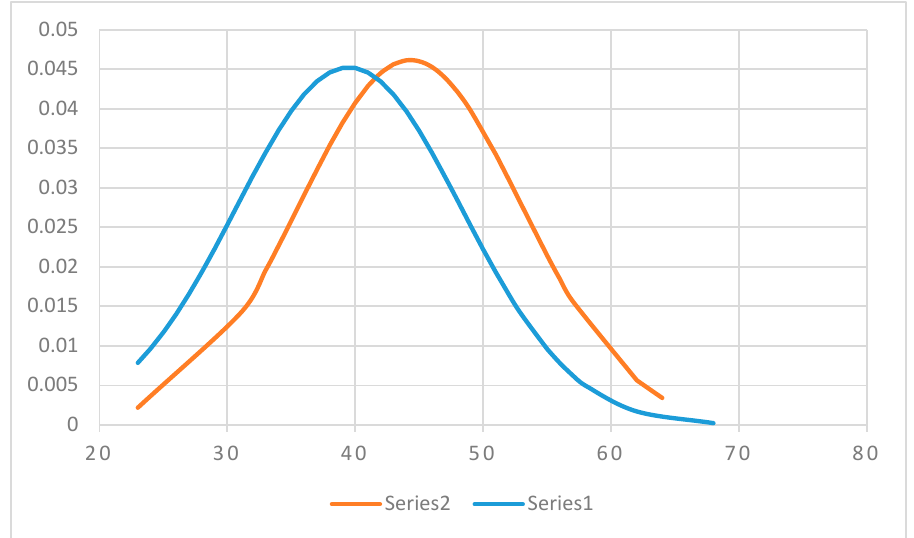
Figure 6. Simple (Series 1) and complex (Series 2) endometrial hyperplasia histopathological (HP) diagnosis distribution, according to patient age